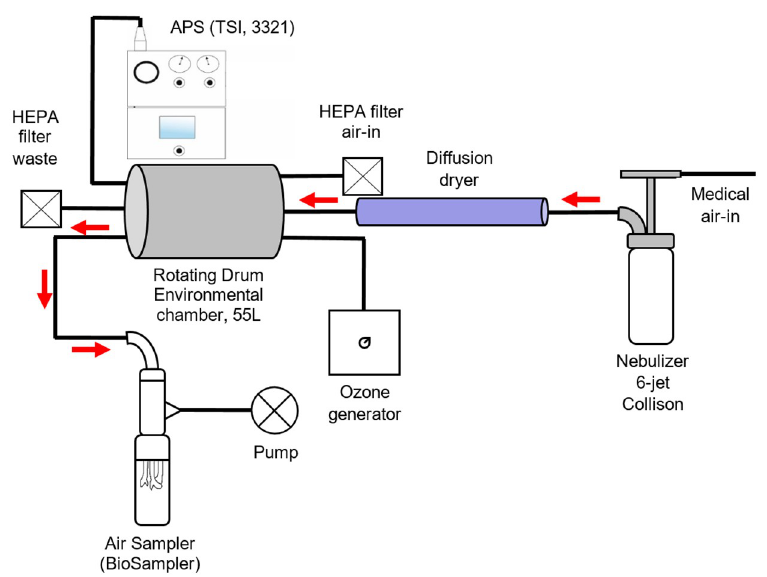
Fig 1. Complete environmental aerosol chamber set